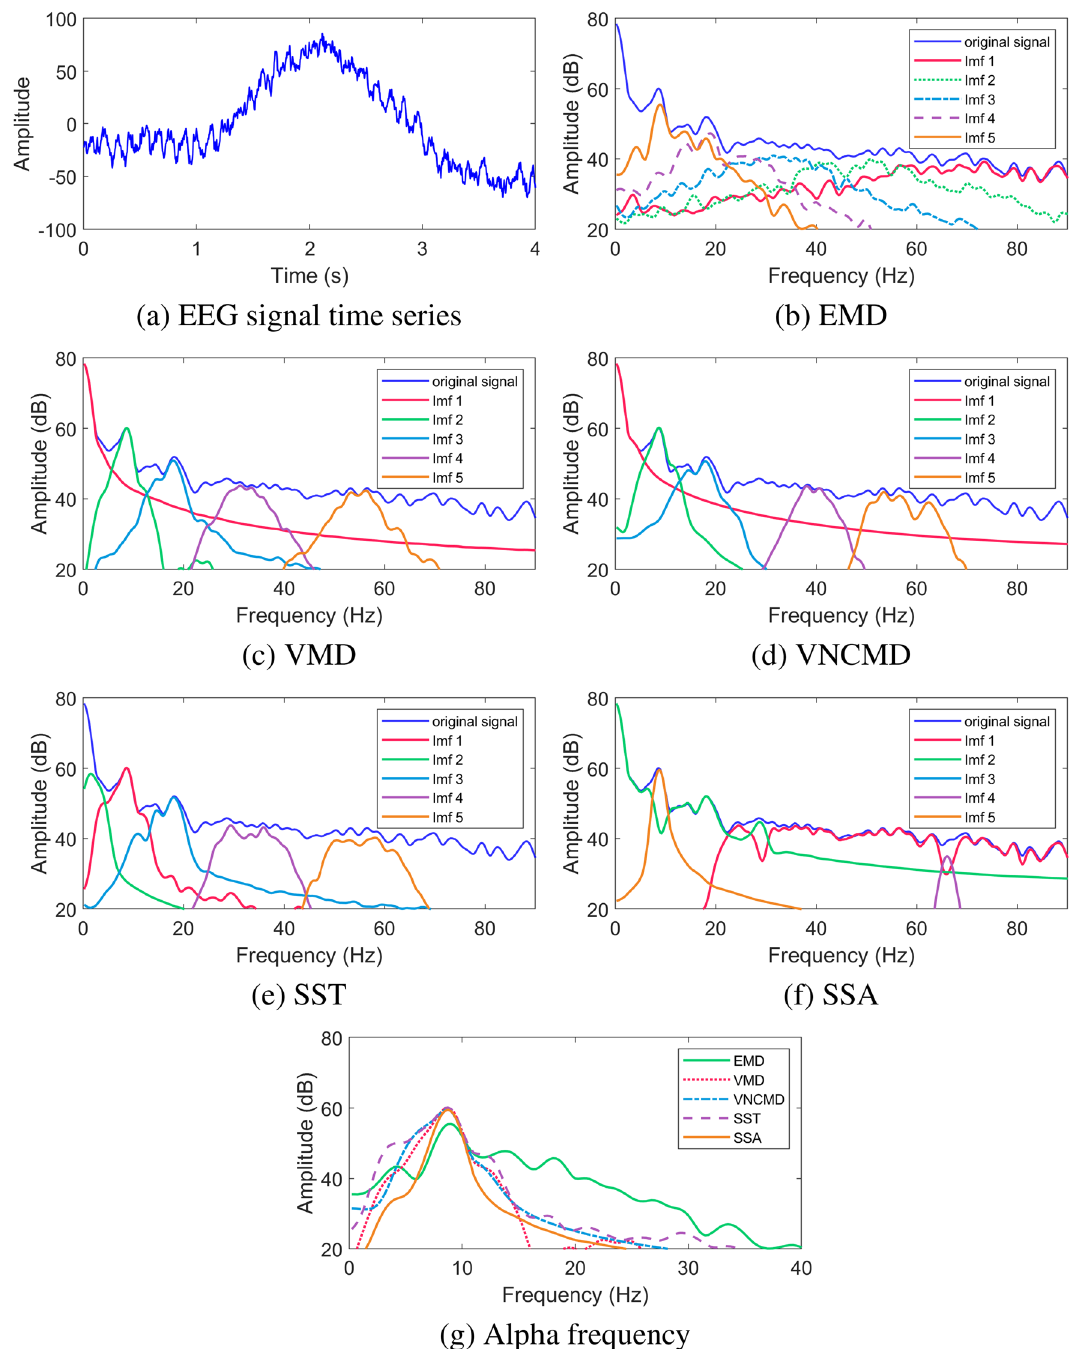
Figure 4. Results of SD methods applied on a real-life EEG data. The original time-series is shown in ( a ), while the spectra of the K = 5 decomposed components are shown for EMD ( b ), VMD ( c ), VNCMD ( d ), SST ( e ) and SSA ( f ). The spectra of the relevant modes (corresponding to the α frequency range (8–10 Hz)) obtained from different methods are shown in ( g